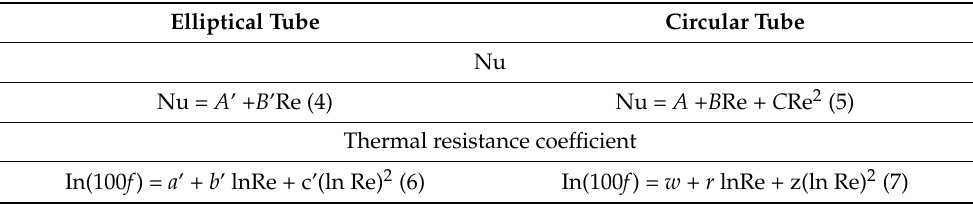
Table 2. Average Nu and thermal resistance coefficient equations for elliptical (semicircular) and circular tube